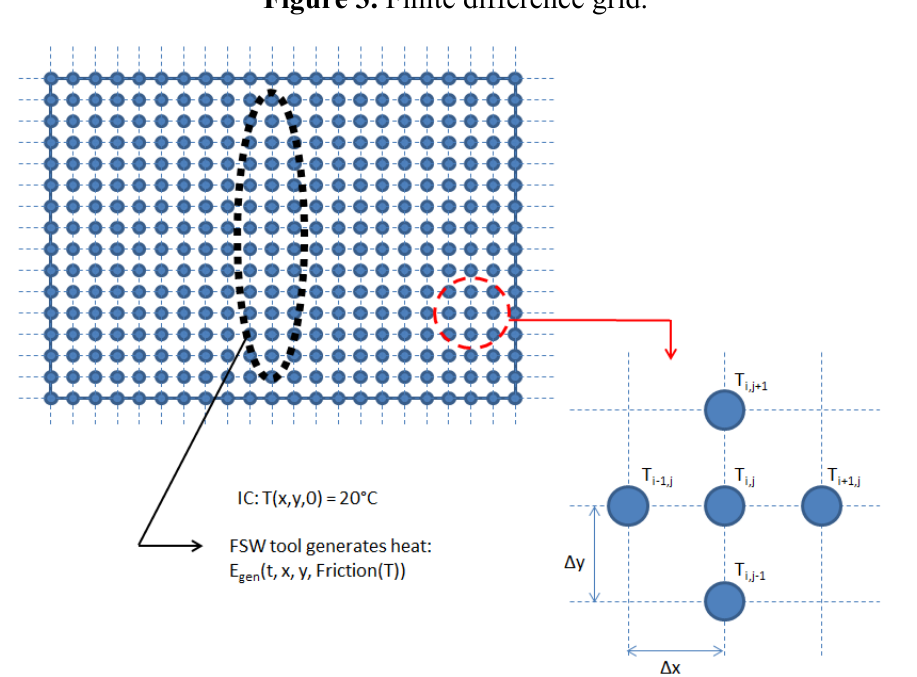
Figure 3. Finite difference grid.